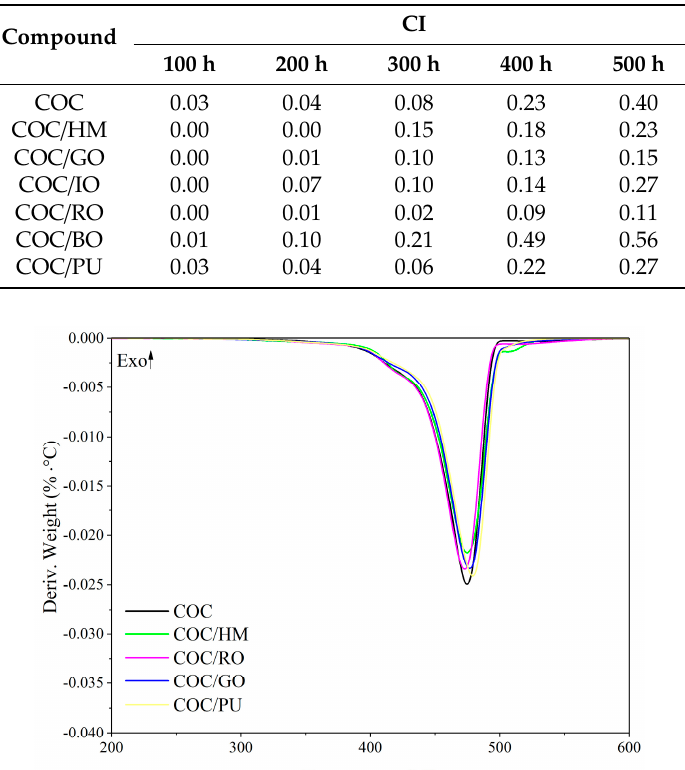
Table A2. Carbonyl index (CI) parameter of samples exposed to different aging times.